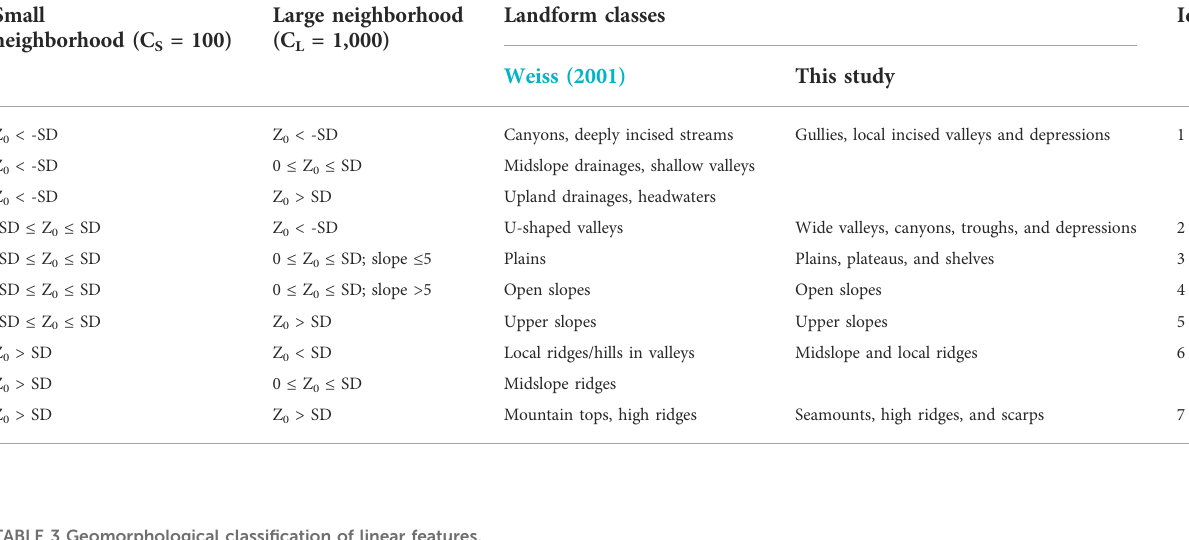
TABLE 3 Geomorphological classi fi cation of linear features.